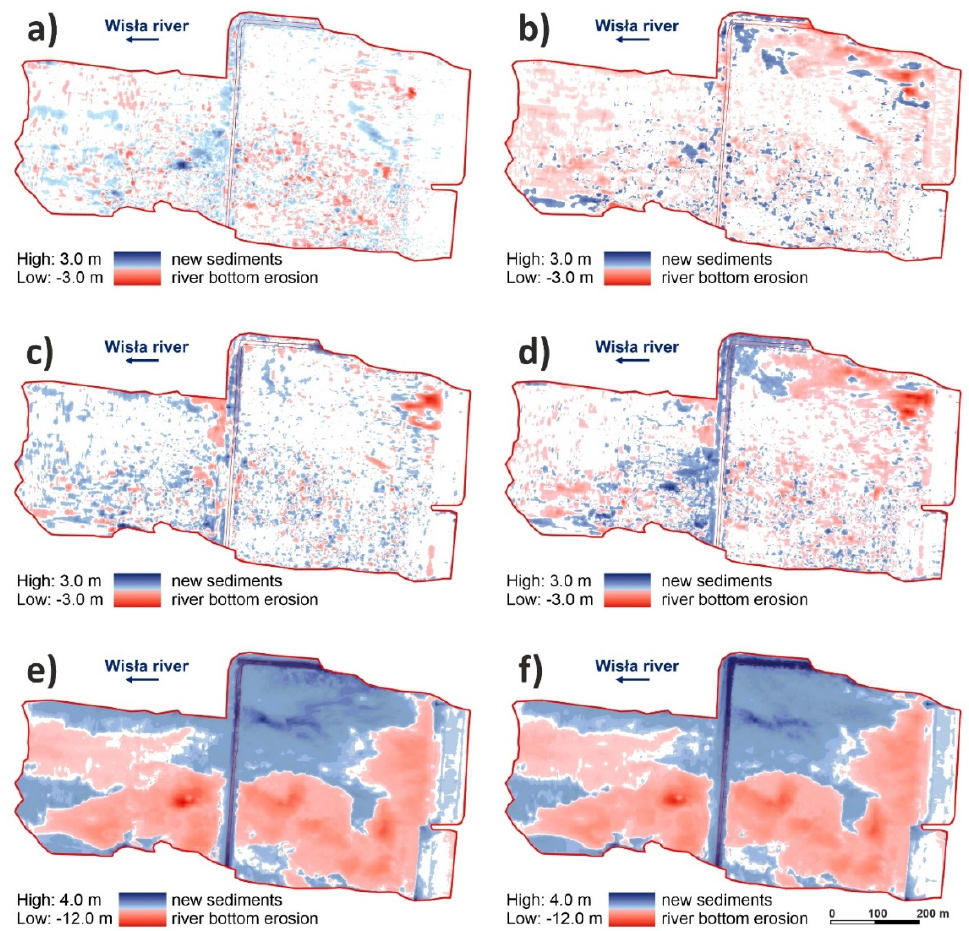
Figure 8. The situation of changes in river bottom surface (river bottom erosion, new sediment), ( a ) between the first and second year of monitoring, ( b ) between the second and third year of monitoring, ( c ) between the third and fourth year of monitoring, ( d ) between the first and fourth year of monitoring, ( e ) between the first year of monitoring and 1970, ( f ) between the fourth year of monitoring and 1970.